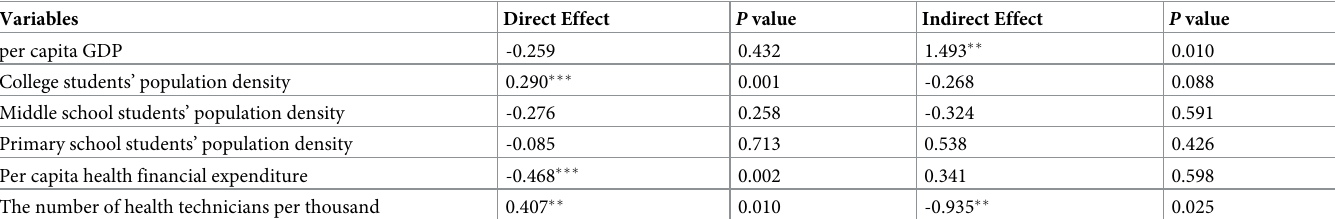
Table 3. Estimation results of the spatial effect decomposition of the Spatial Durbin